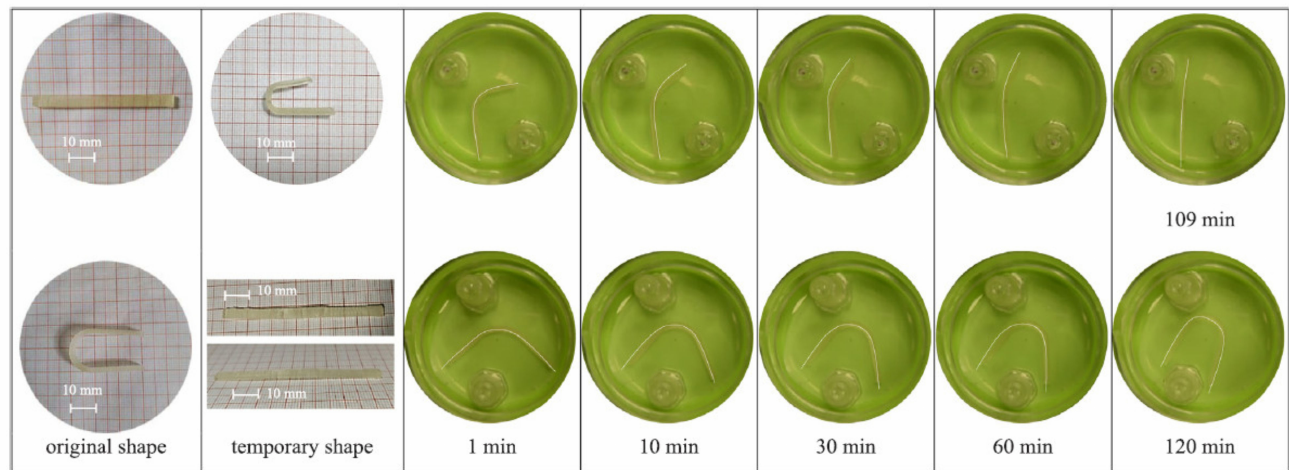
Figure 3. Images depicting the shape recovery process of the intravesical device (at around 20–22 ◦ C) over time, which was created using FDM 3D printing and having a unique I- and U-form. To accentuate the recovery phase, a solid line is